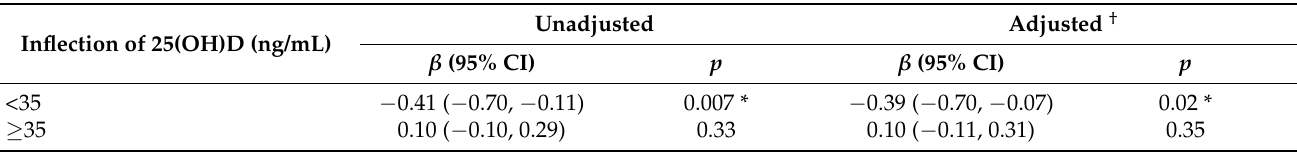
Table 4. Threshold effect analysis of 25(OH)D at 6 months and weight-for-length percentile in infants at 12 months using piecewise linear regression ( n = 925).